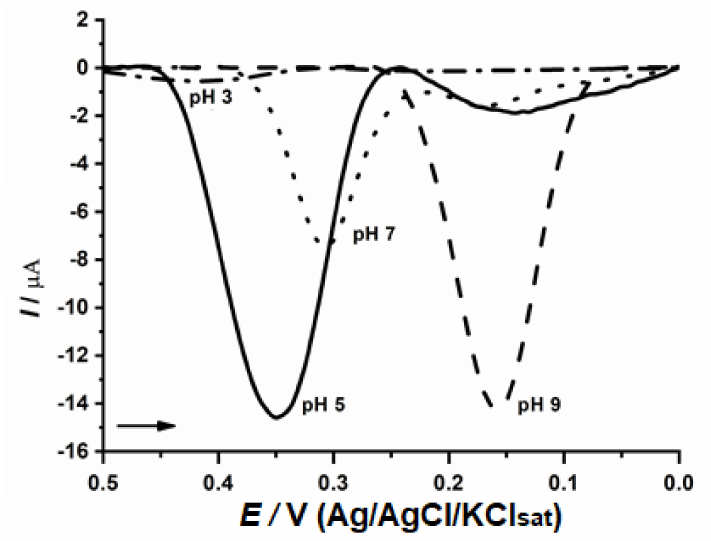
Figure 4. Determination of optimal pH with CP-50ME in 40 µ M catechin solution in sodium acetate buffer pH 3.0 and 5.0 and sodium phosphate buffer pH 7.0 and 9.0, after 2 min of enzymatic reaction.